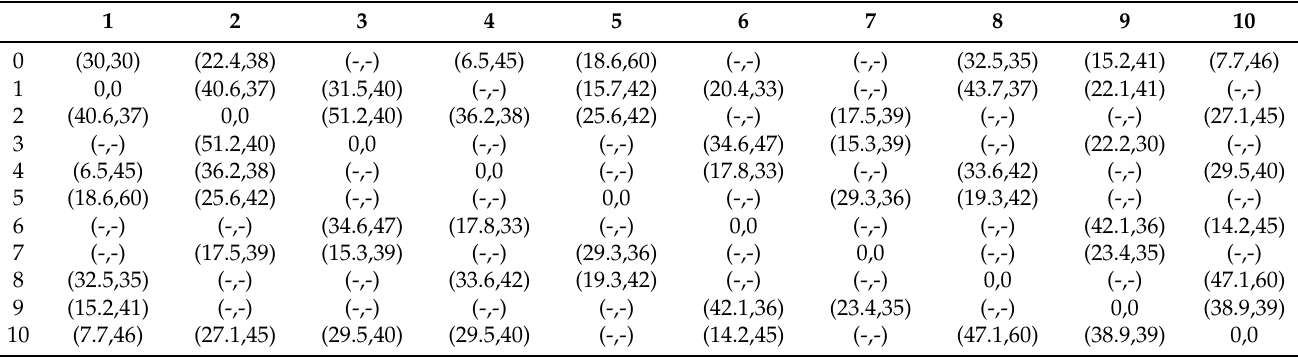
Table 5. Transport network